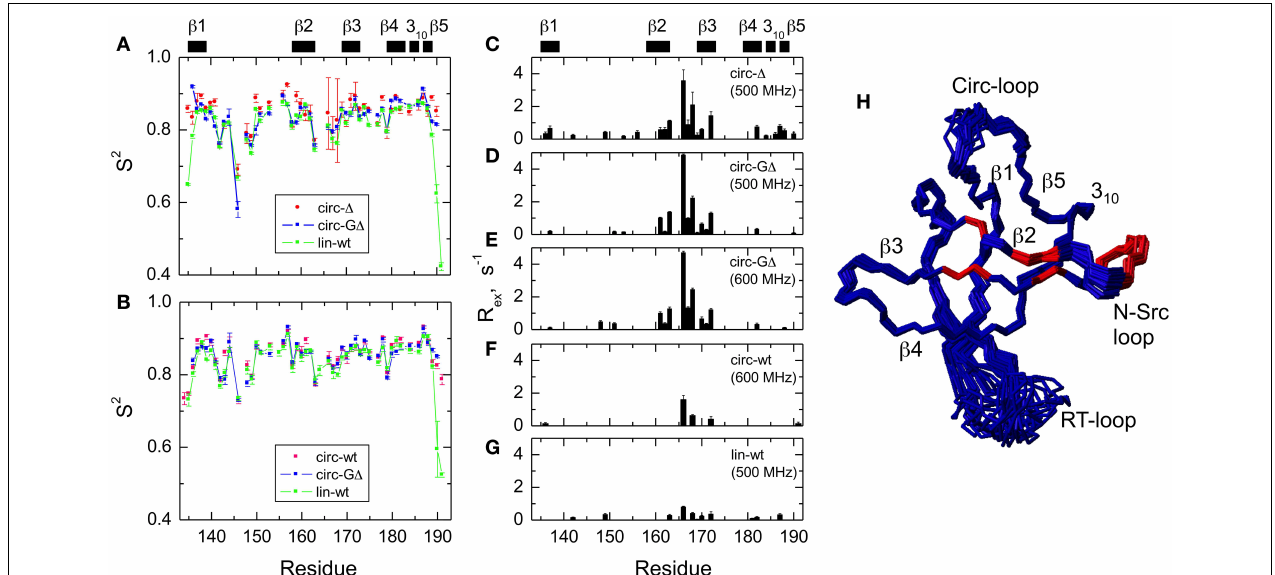
sub-nanosecond motions while the red coloring indicates the sites involved in conformational exchange. For comparison with the 500 MHz data, the R ex values shown in panels (E) and (F) were reduced by a factor of (1.2) 2 which represents the expected field dependence ( ∝ B 2 o ) of the R ex term. SH3 circ - G 1 data at both magnetic fields are shown here to illustrate the reproducibility of the results. A similar agreement was observed between R ex terms measured in SH3 lin - wt at 600 MHz (not shown) and those in (G) . Horizontal bars on the top indicate the location of the secondary structure